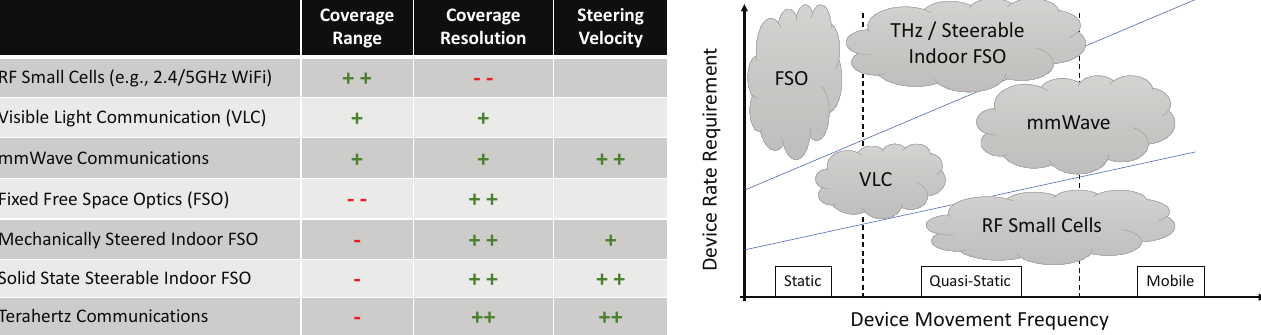
Figure 2. Generalized evaluation of link technology characteristics ( left ) and a context-of-use based analysis of preferred link technologies ( right ). We consider VLC as LED-based systems for both lighting and communications. FSO is broadly categorized as fixed building-to-building FSO or short range steerable FSO for indoor communications. Range directly related to potential coverage. Resolution is inversely related to instantaneous coverage. Absence of + or − indicates that the technology is typically